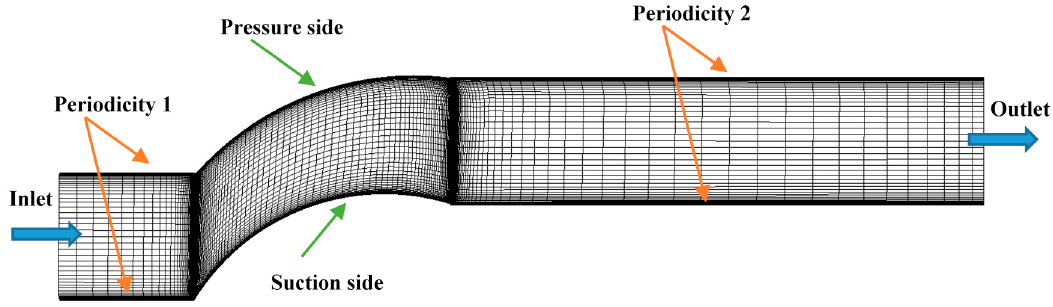
Figure 2. Computational domain (grid) and imposed boundary conditions.